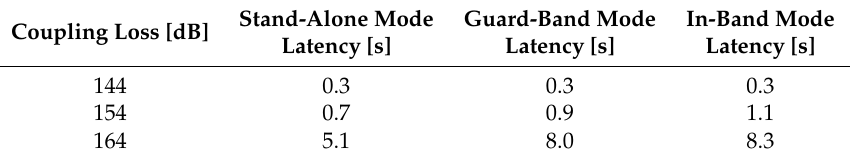
Table 1. NB-IoT exception report latency (adapted from